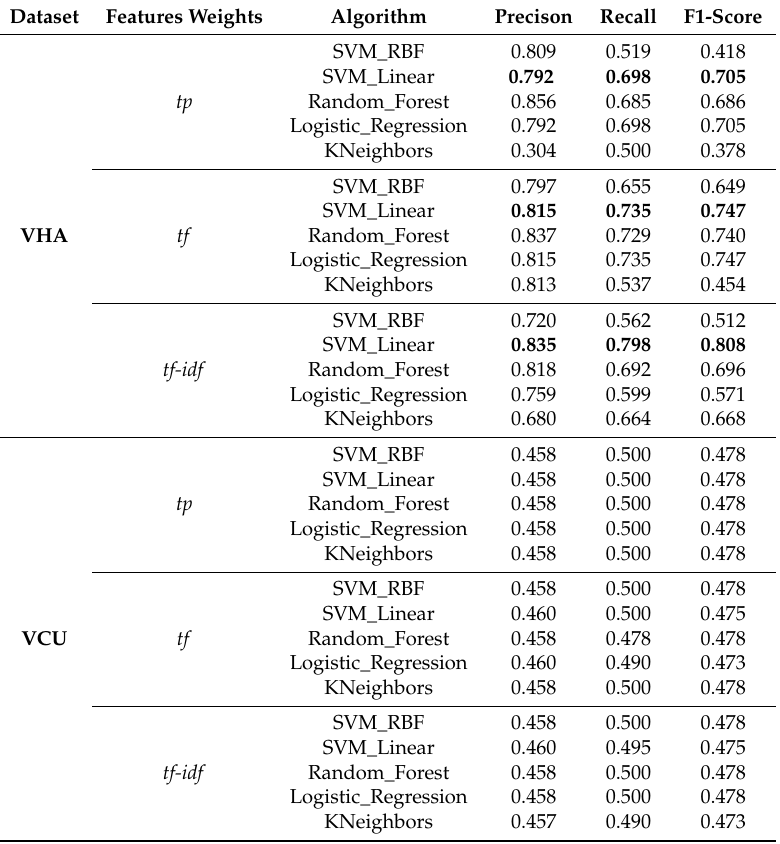
Table 3. Model-2 selection results for severity categorization using traditional machine learning approach. Results reported are macro-averaged. Bold values indicated best results generated by feature weights and algorithms